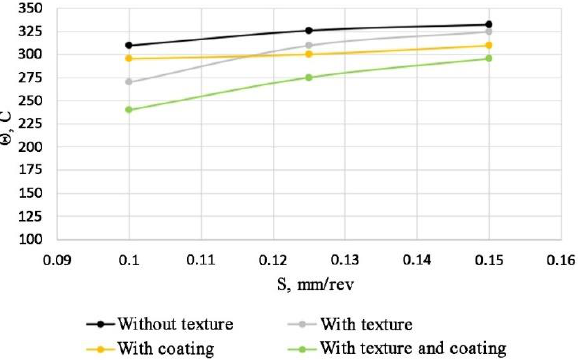
Figure 9. Dependence of the cutting temperature on the feed per revolution for various tools at a cutting speed of V = 17 m/min and t = 0.5 mm/rev.